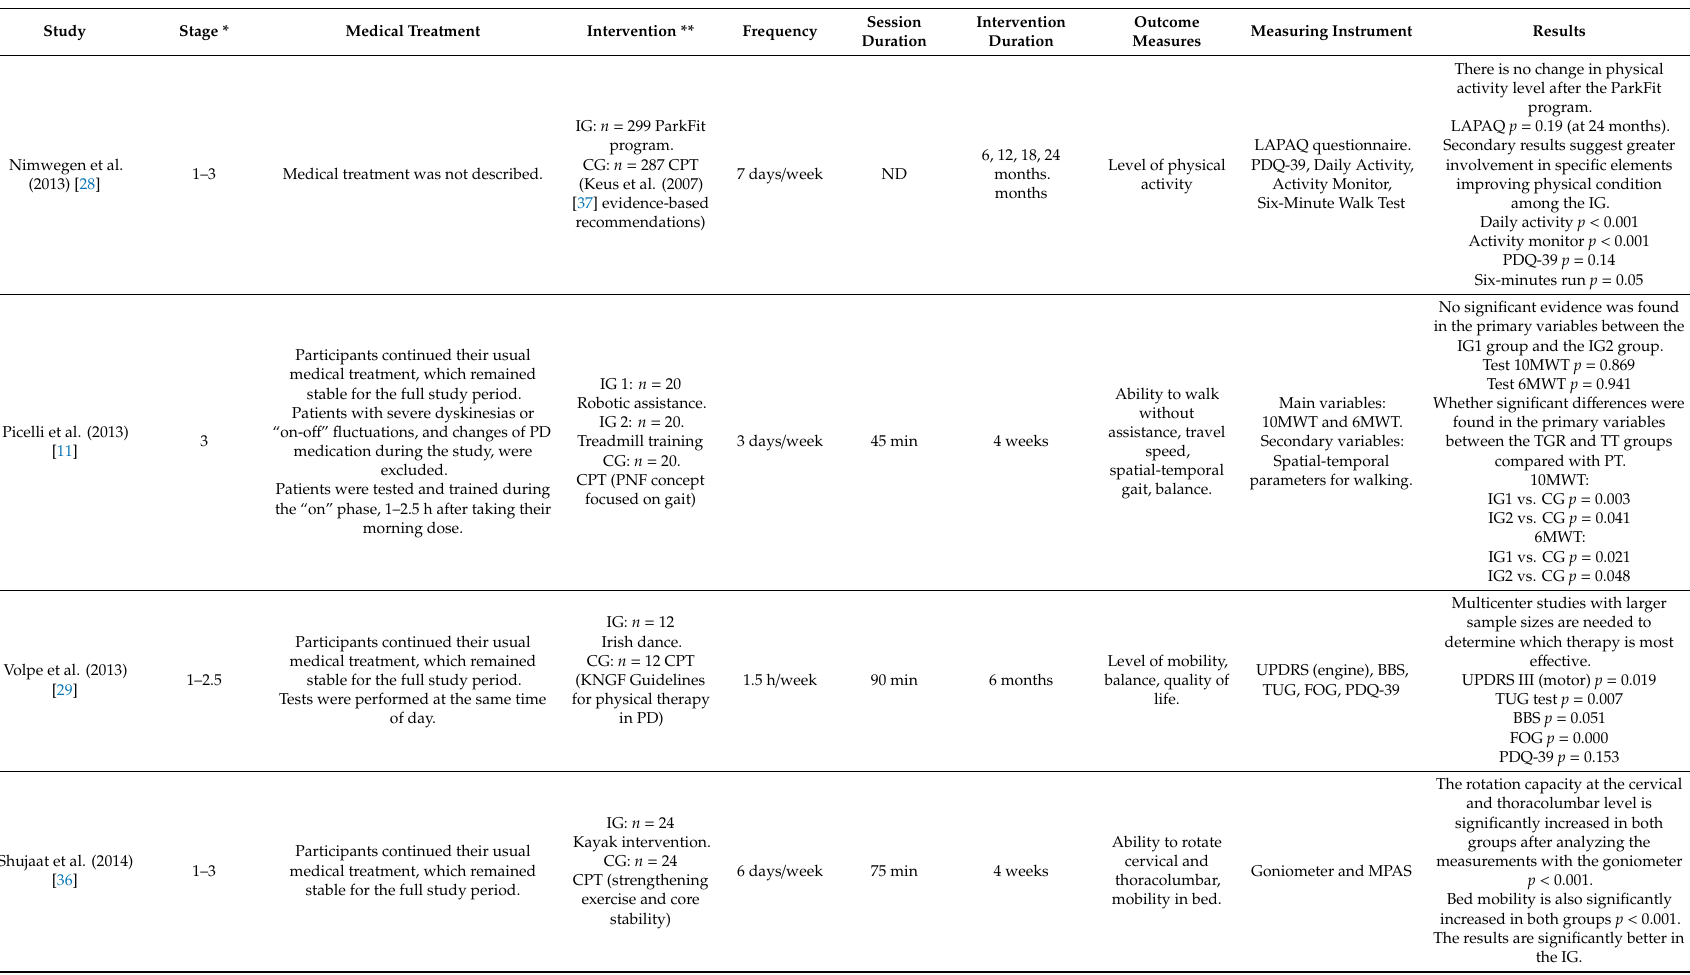
Table 3. Main characteristics of the interventions.